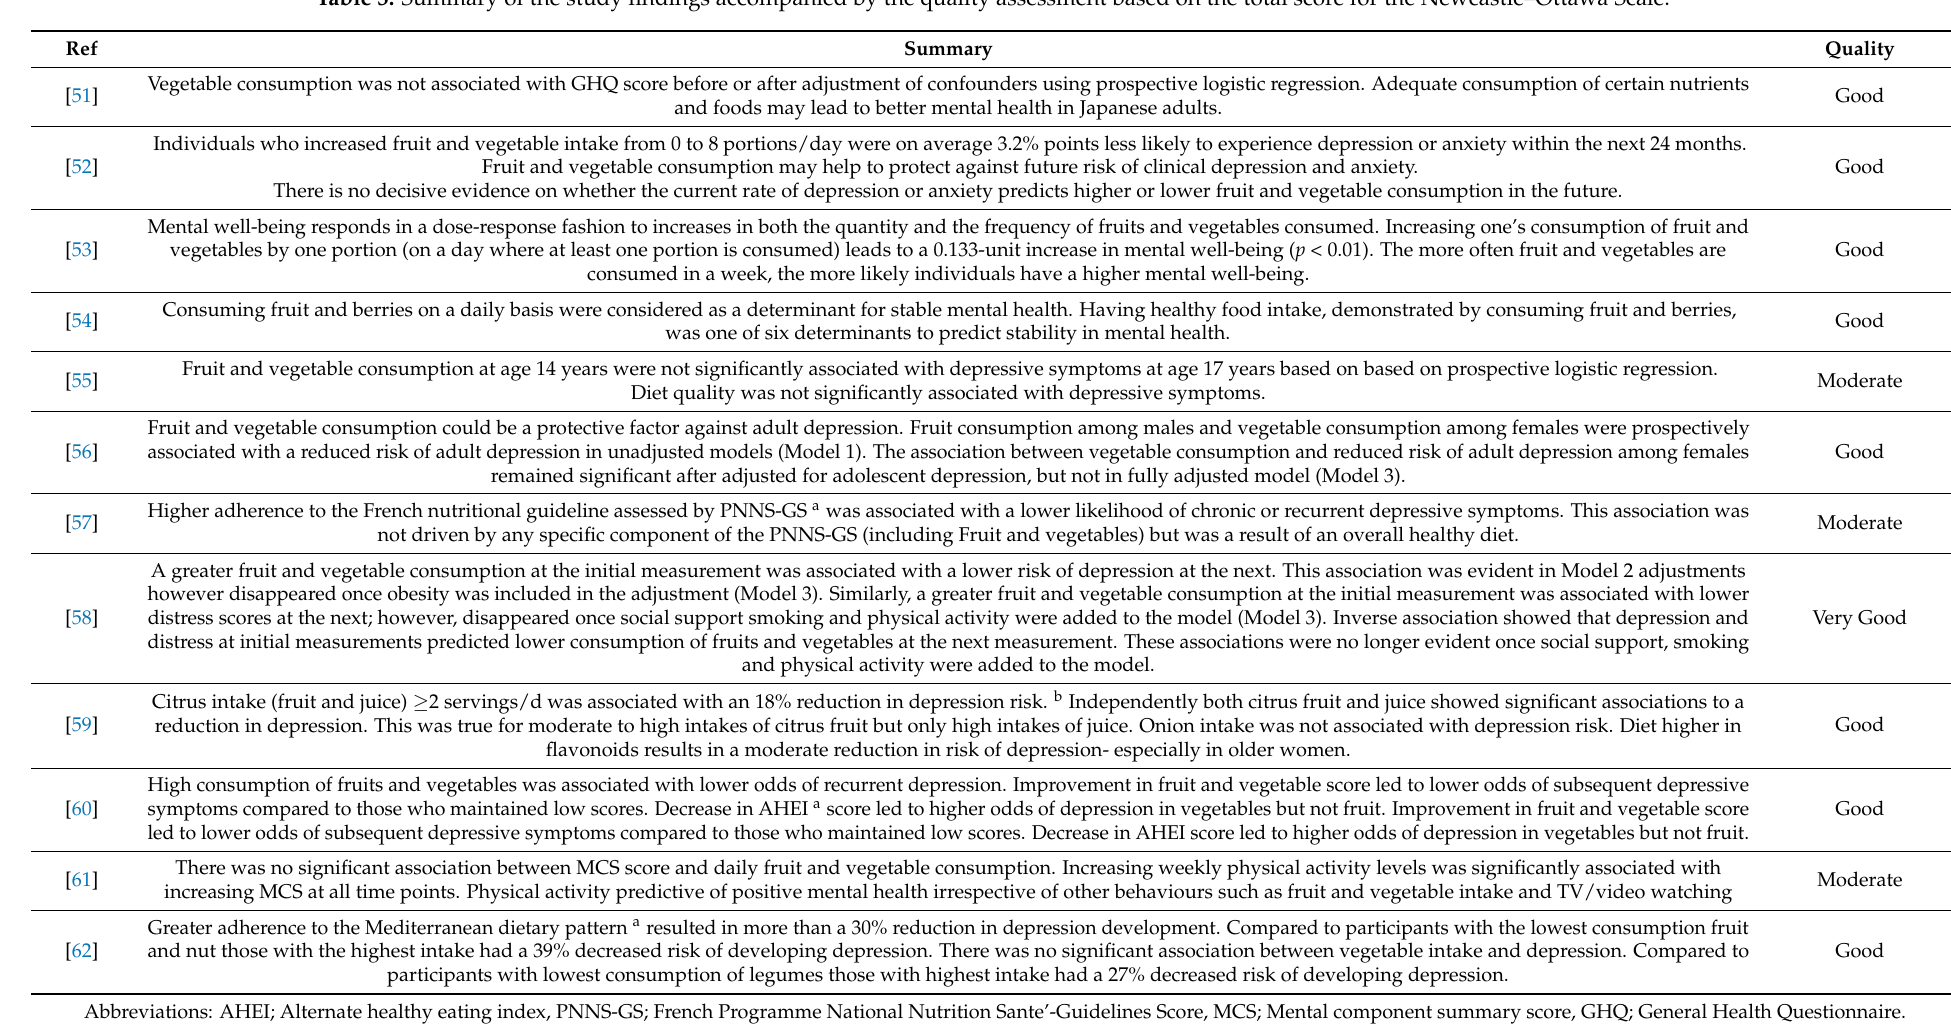
Table 3. Summary of the study findings accompanied by the quality assessment based on the total score for the Newcastle–Ottawa